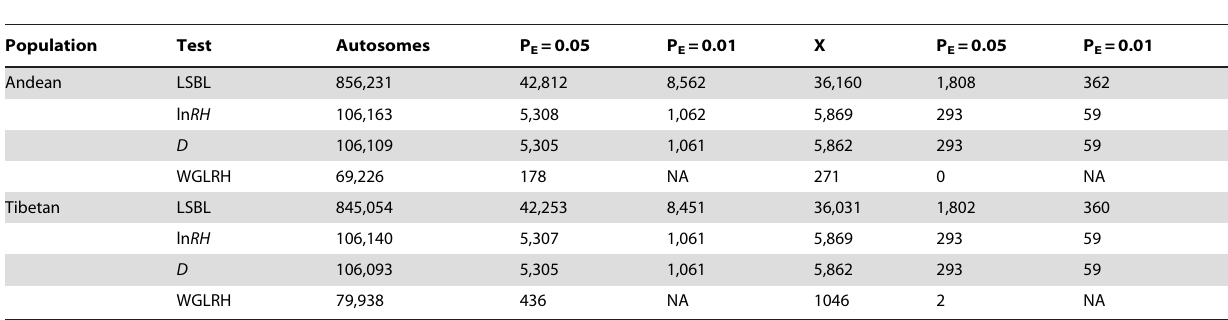
Table 1. Significant SNPs or SNP windows in Andeans and Tibetans for P E # 0.05 and P E # 0.01.